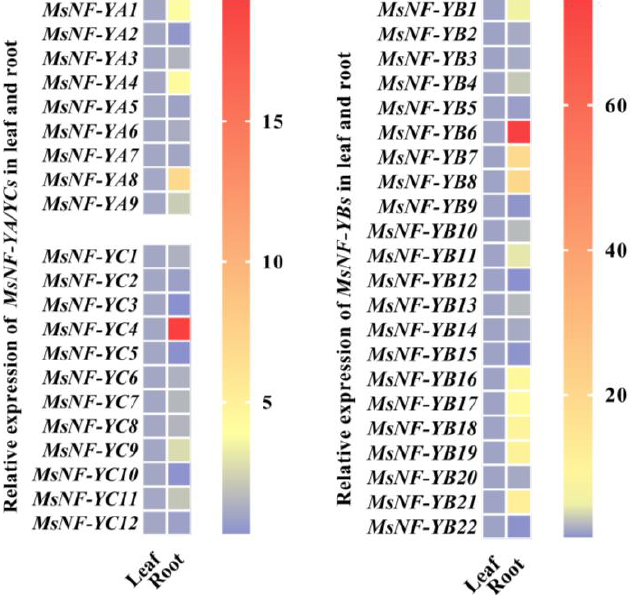
Figure 2. MsNF-Ys behaved differently in the leaves and roots. The heat map shows the relative mRNA level of MsNF-Y genes in the leaves and roots. Apple Histone H3 was chosen for the internal quantification control of the MsNF-Y genes. The expression of each MsNF-Y gene in the leaves was normalized to 1.